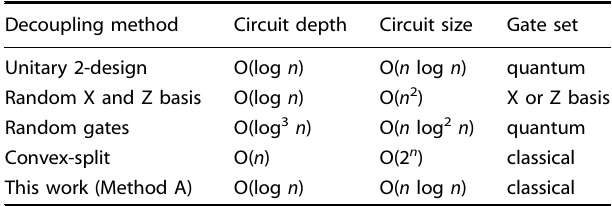
Table 1. Parameters of various decoupling methods (Unitary 2- design 47 , Random X and Z basis 49 , Random gates 48 , Convex-split 54 , this work (Method A